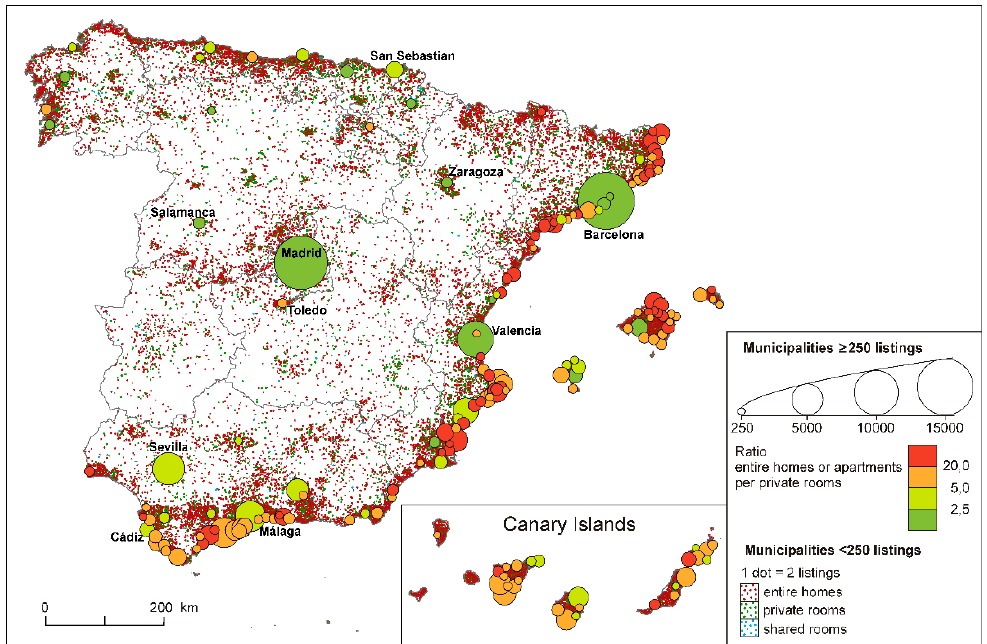
Figure 1. Distribution of Airbnb listings in Spanish municipalities.